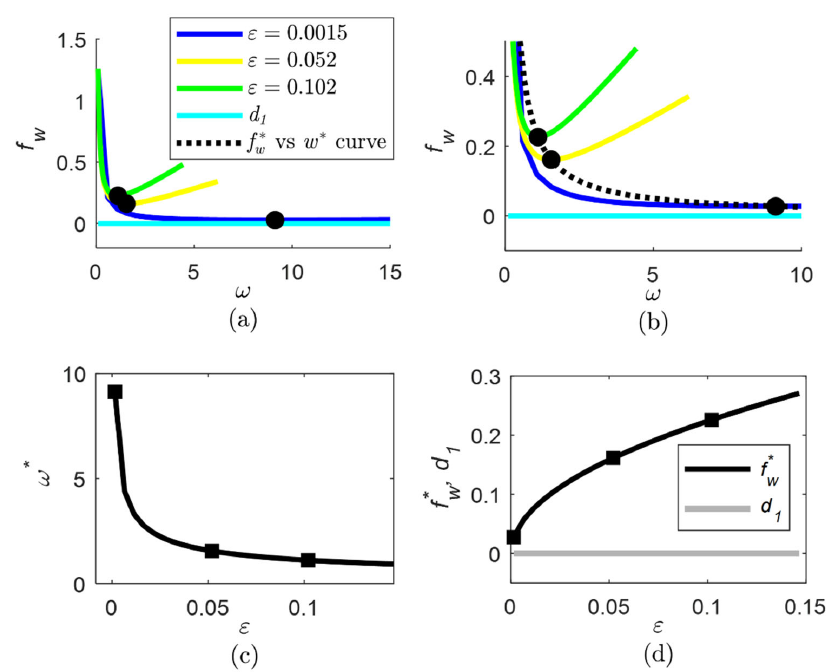
Figure 2. Effect of the observer parameters ε , ω on the f w function (20) for estimation of the specific substrate uptake rate ρ : ( a ) f w as a function of ω for several ε values, indicating the minimum point; ( b ) detail of f w as a function of ω for several ε values, indicating the minimum point; ( c ) values of ω ∗ as a function of ε , indicating the points for the ε values considered in subfigure a; ( d ) values of f ∗ w as a function of ε , indicating the points for the ε values considered in subfigure a.